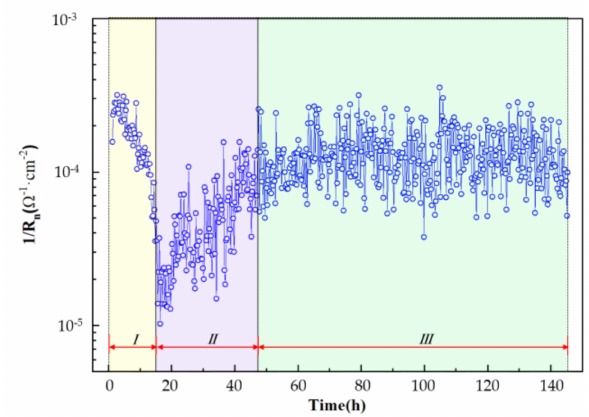
Figure 10. The inverse of noise resistance (1/ R n ) of Al–BN